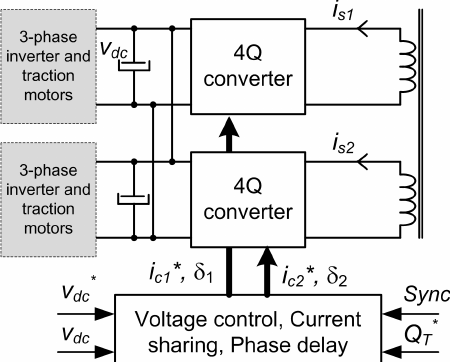
Figure 10. Hierarchical control of the four-quadrant converters.